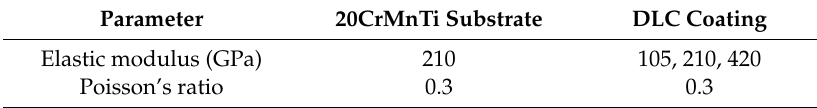
Table 2. Mechanical properties of the substrate and coating materials.